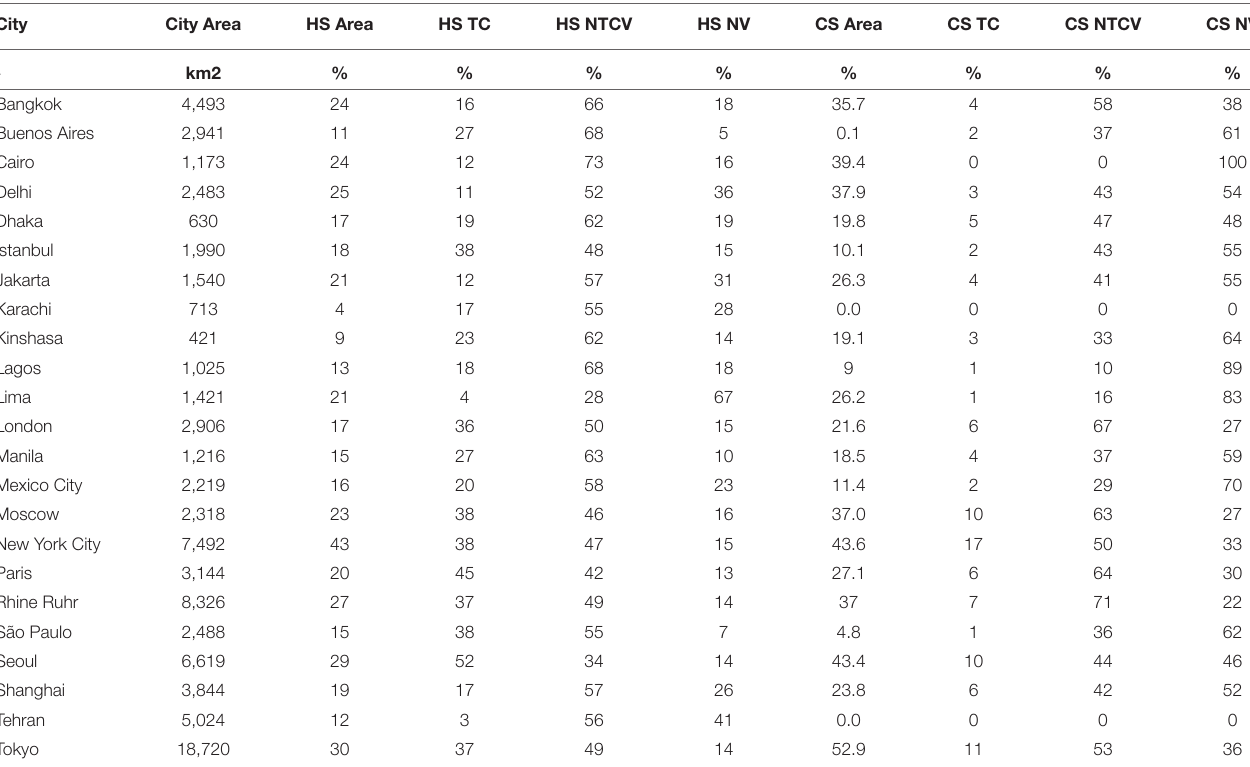
TABLE 3 | Megacity area (%) in tree cover (TC) hot spots (HS) and TC cold spots (CS), identified at a 5% significance based on Getis Ord analysis of MOD44B TC data, and the average estimated TC, non-tree cover vegetation (NTCV), and non-vegetation (NV) in those hot spot and cold spot areas.